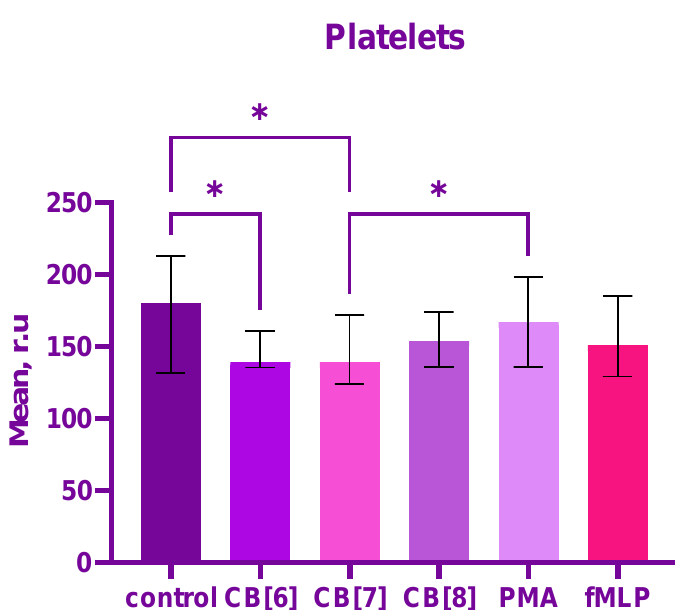
Figure 2. Graph of the fluorescence intensity of platelets, producing reactive oxygen species in response to stimulation with cucurbiturils (CB [6,7,8]) during 1 h. Data are presented as median ± interquartile range with n = 10. * p < 0.05 by employing one-way ANOVA, Friedman test. Interestingly, CB[n] had low effect on mononuclear cells. Percentage of ROS-produc-